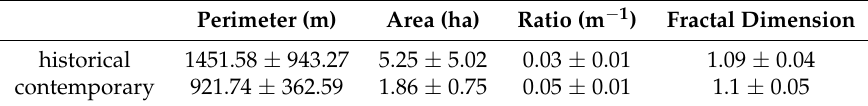
Table 4. Landscape metrics for historical and contemporary deforestation patterns: We report patch perimeter and area, their ratio, and fractal dimension. Values are reported as mean ± standard deviation across all deforestation